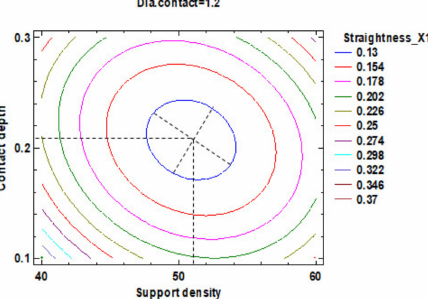
Figure 14. Contours of Estimated Response Surface for Straightness_X1 and centre diameter contact.